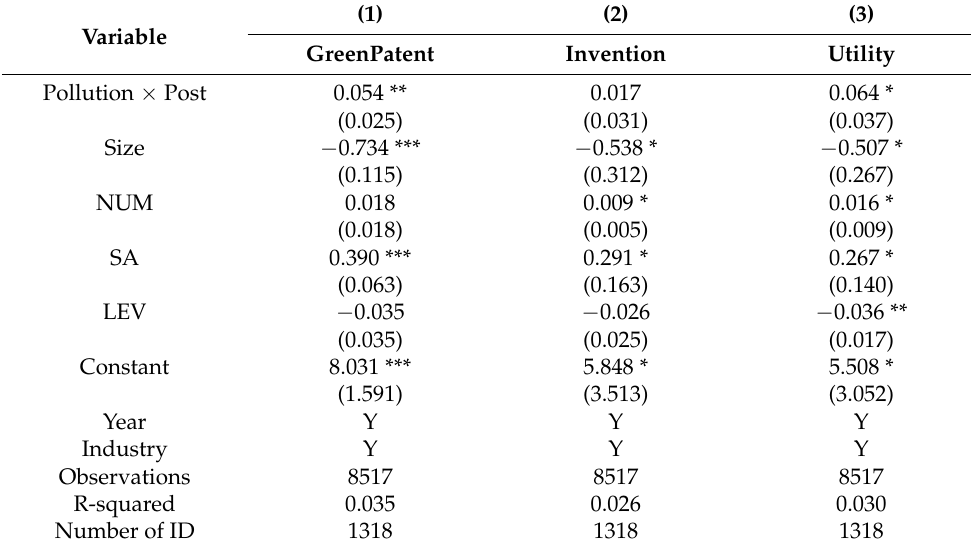
Table 5. Environmental regulation and corporate green innovation: bootstrap.